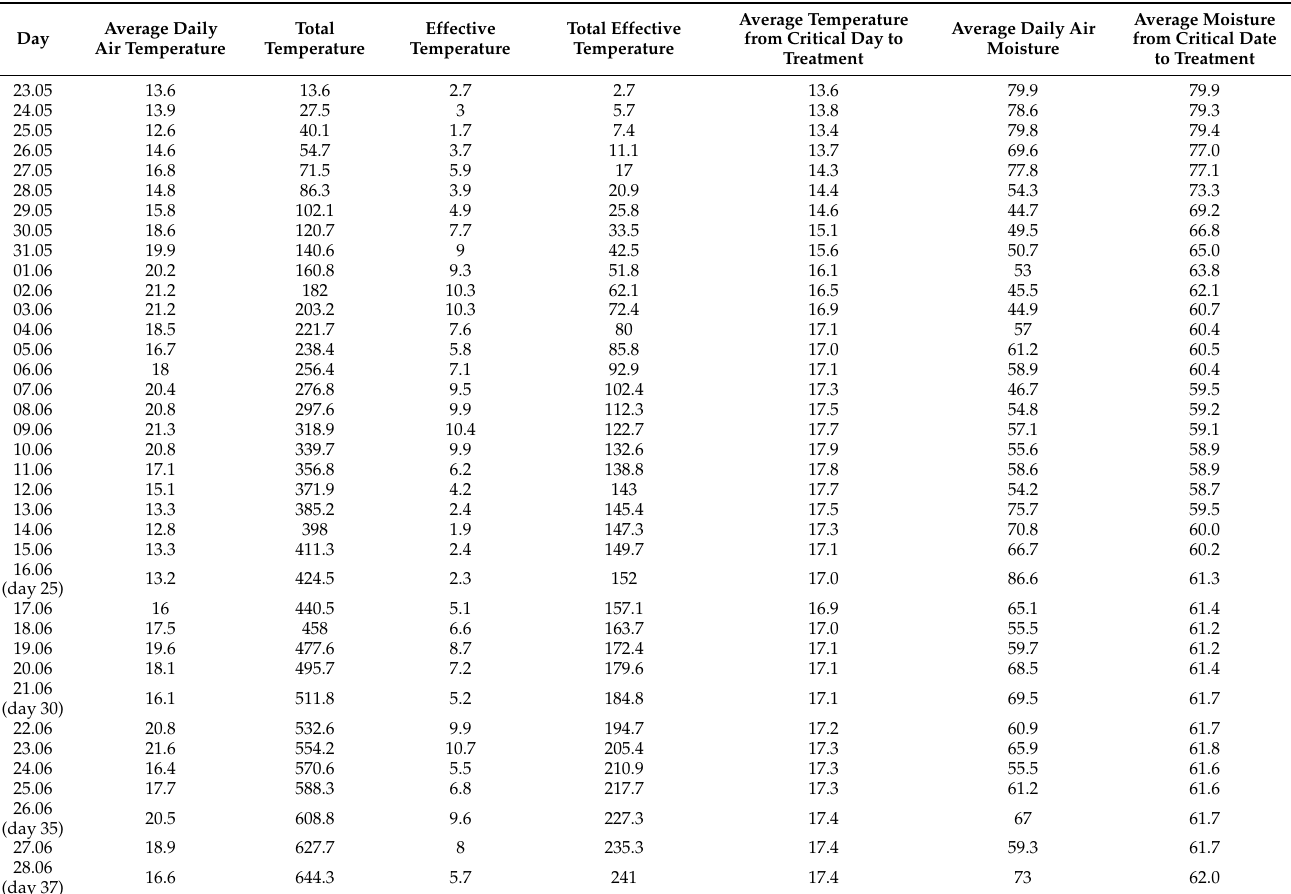
Table 4. Weather data used to arrive at treatment date in Winna G ó ra in 2008.